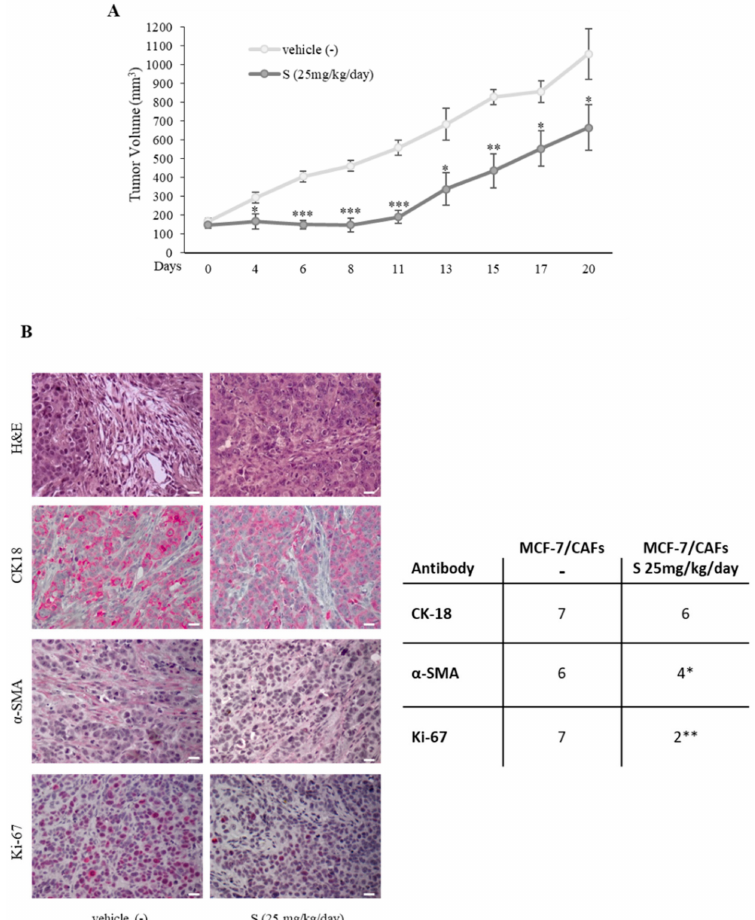
Figure 3. Impact of sildenafil treatment on tumor growth of MCF-7 / CAF xenografts. ( A ) MCF-7 cells were co-injected with CAFs subcutaneously into nude mice (8 mice / each group). Vehicle ( − ) and sildenafil treatment (25 mg / kg / day) were started when tumor size reached 150 mm 3 (day 0) and delivered daily to the animals by intraperitoneal (i.p.) injection. Tumor volume mean ± SEM is shown. ( B ) Left panel, representative images of hematoxylin and eosin (H&E), human cytokeratin 18 (CK18), α -SMA, and Ki-67 immunohistochemical staining of MCF-7 / CAF xenograft tumor sections. Scale bar = 25 µ m. Right panel: immunohistochemistry scores. Cases were scored according to Allred immunohistochemistry (IHC) score [28] which includes both the proportion and intensity scores (range from 0 to 8). * p < 0.05; ** p < 0.005; *** p <